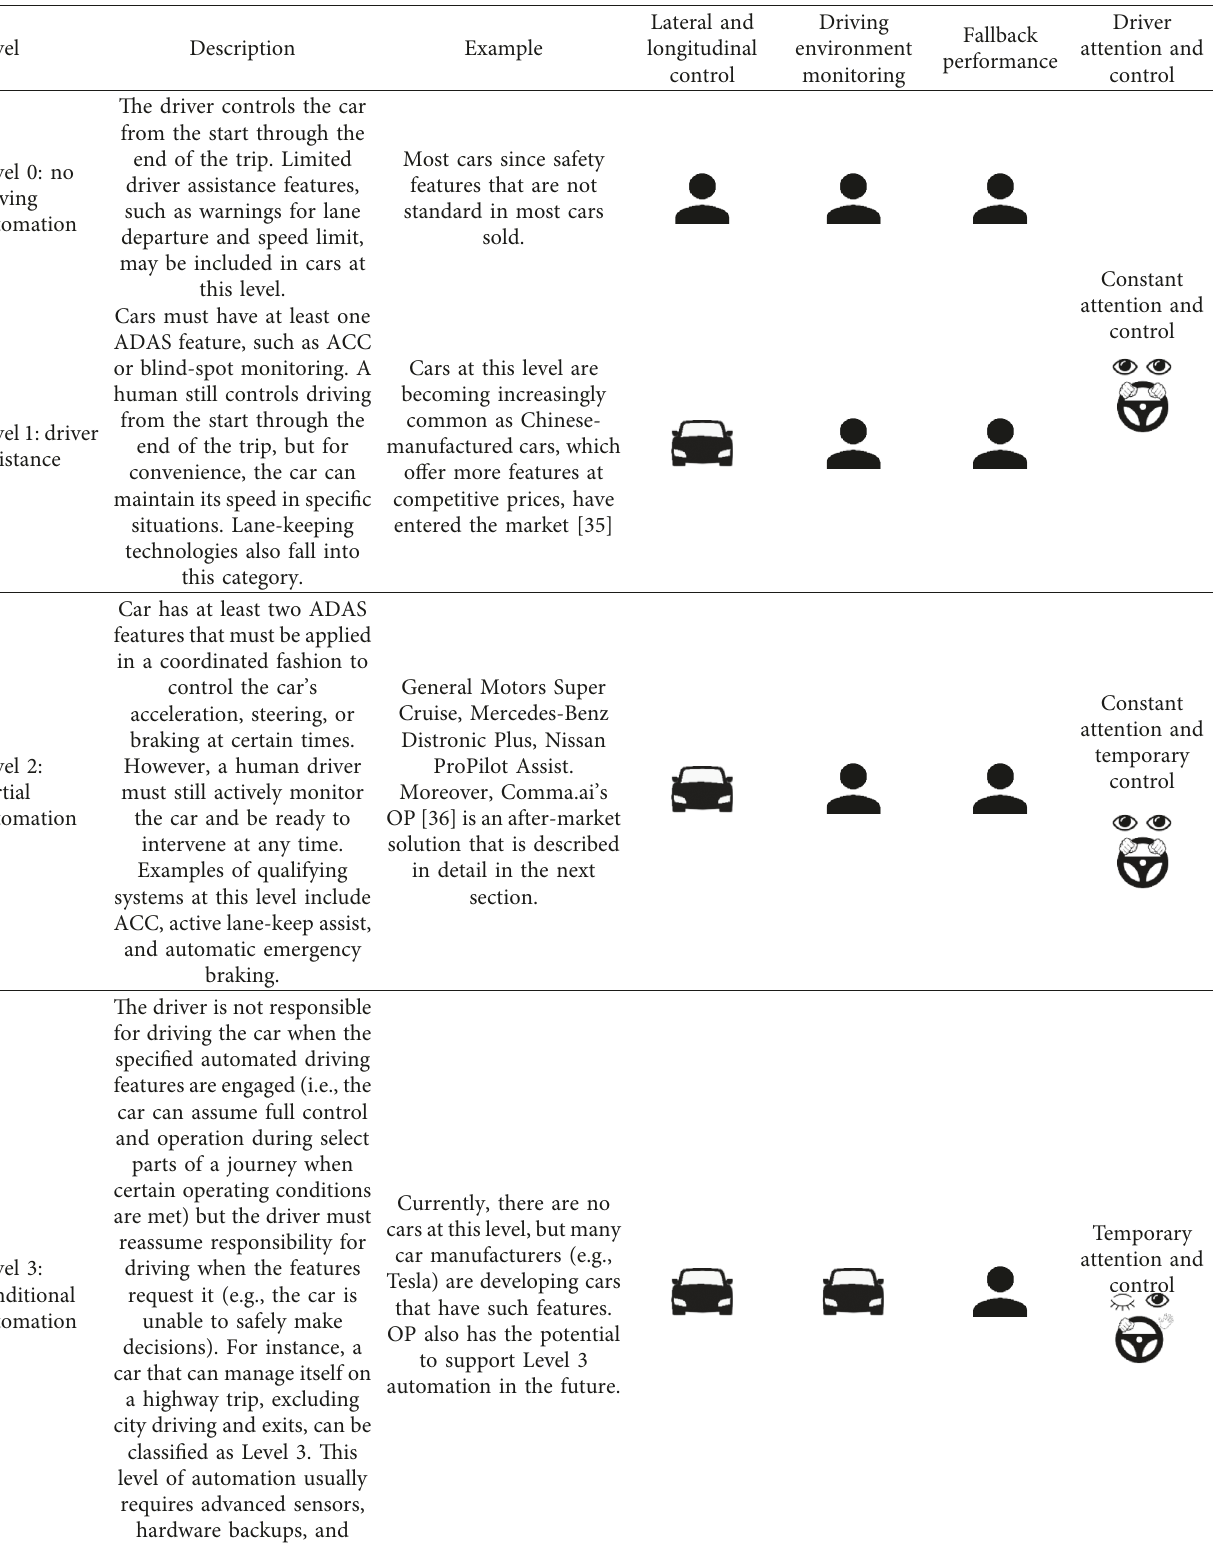
Table 1: Comparison of driving automation levels